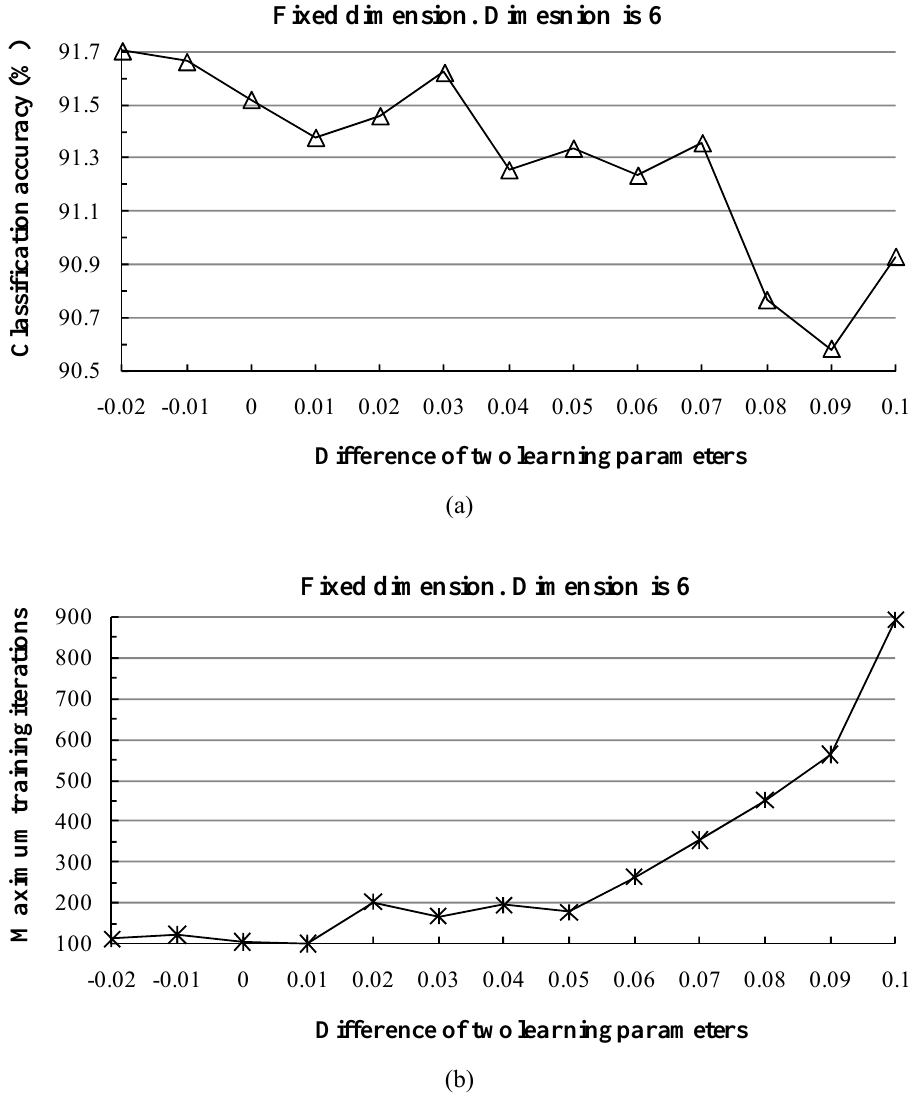
Figure 5. Plots of the difference between  and  vs. (a) classification accuracy and (b) maximum iterations, provided by the fixed subspace method in conjunction with the [0, 1] normalization method. Fixed dimension. Dimesnion is 6